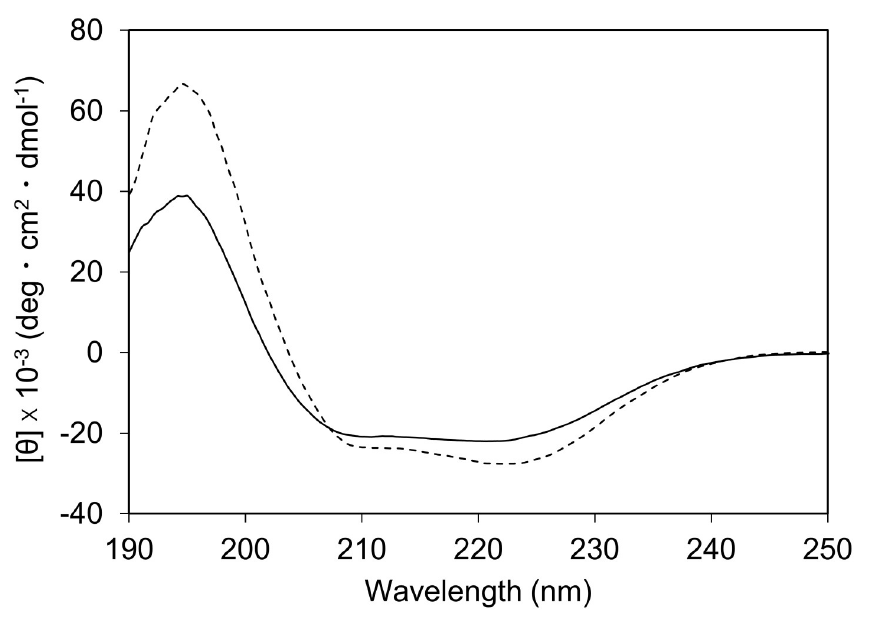
Fig 6. Circular dichroism spectra of Fer8 solution. Fer8 solution obtained after heating the apoferritin hydrogel at 90˚C for 30 min (solid line) and purified Fer8 solution (broken line).